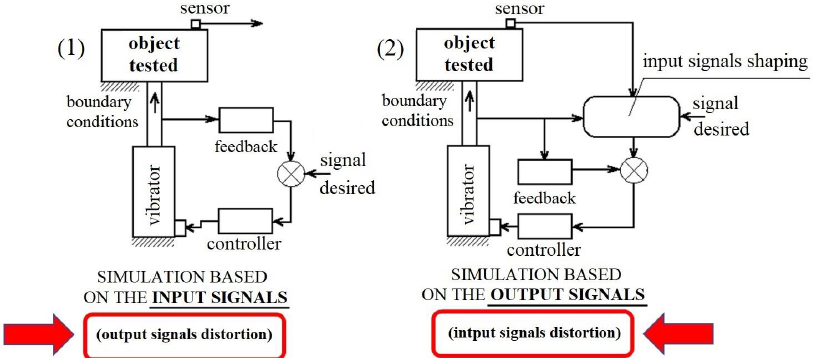
Figure 1. Variants of the approach to the experimental simulation tests. (1) — simulation based on the input signals, (2) — simulation based on the output signals.